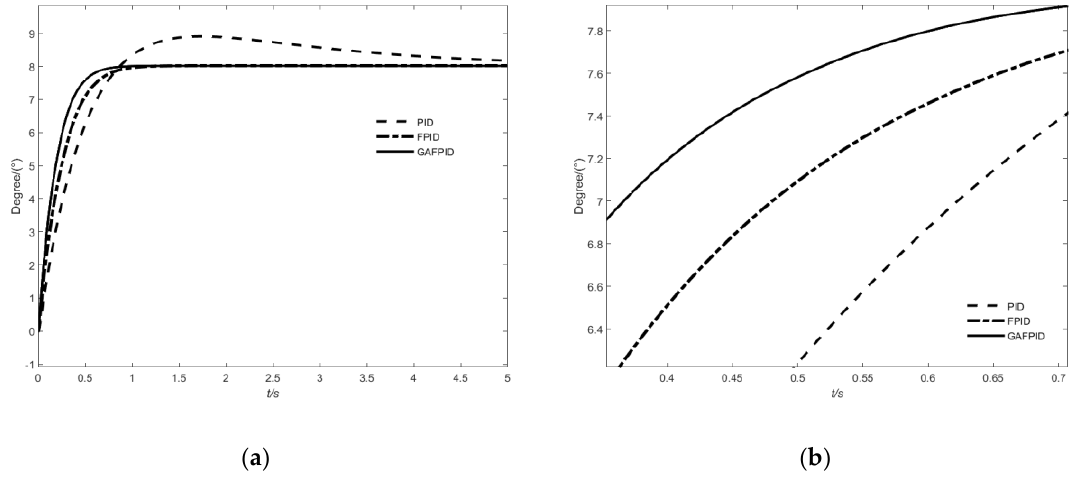
Figure 10. ( a ) Step response; ( b ) local enlarged view. Table 4. Simulation results of the step response.